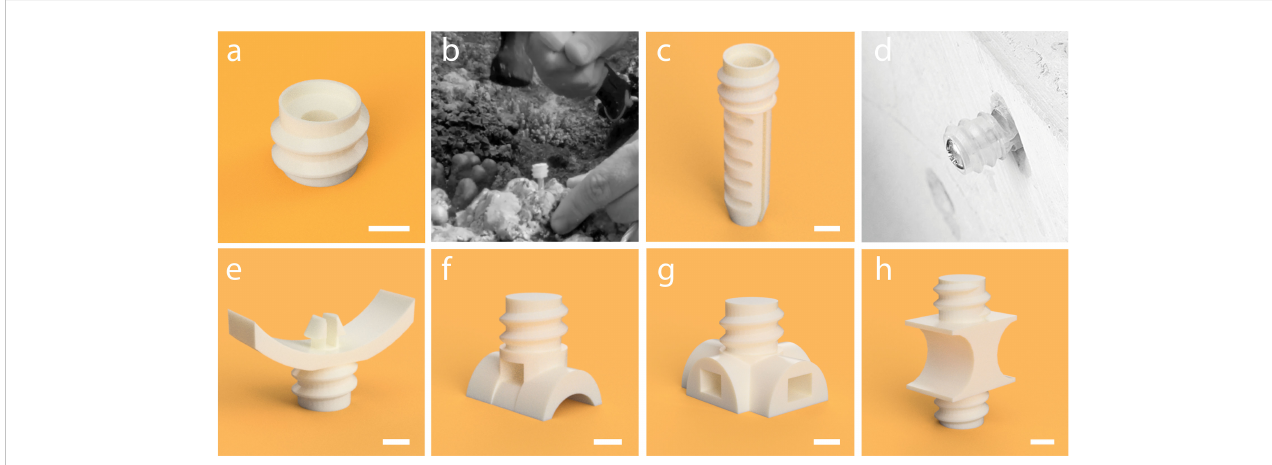
FIGURE 3 Devices for different outplanting/nursery types. (A, B) Maritechture ™ Reef nails for outplanting on natural substrate (patent pending) (C, D) 7 Reef wall plug for outplanting on coral pods, harbor walls, etc. (patent pending) (E-H) . Tools to equip existing nurseries. (E) Clip for PCV pipe nurseries. (F) Adapter for steel/bar nurseries. (G) Adapter for aluminum frame/grid nurseries. (H) Adapter for rope nurseries. White bar indicates 5 mm in